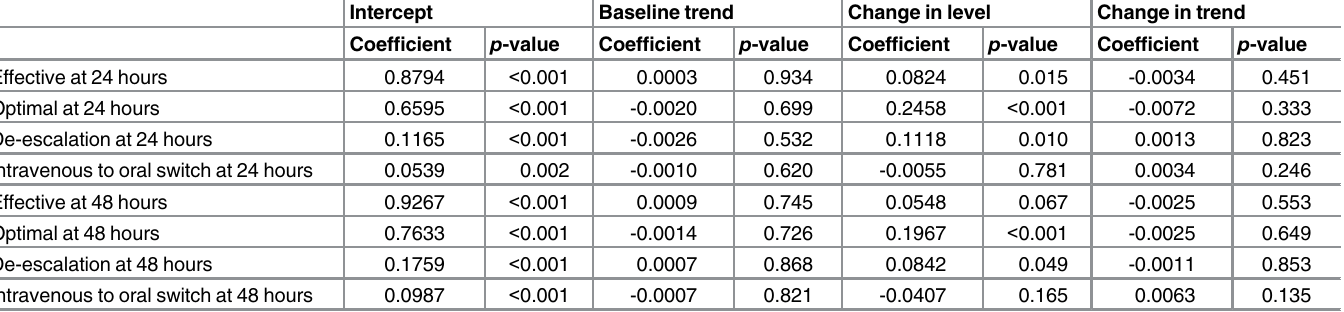
Table 3. Parameter estimates and p -values from the segmented linear regression analysis: proportion of effective, optimal, de-escalation, and intravenous to oral switch therapies per